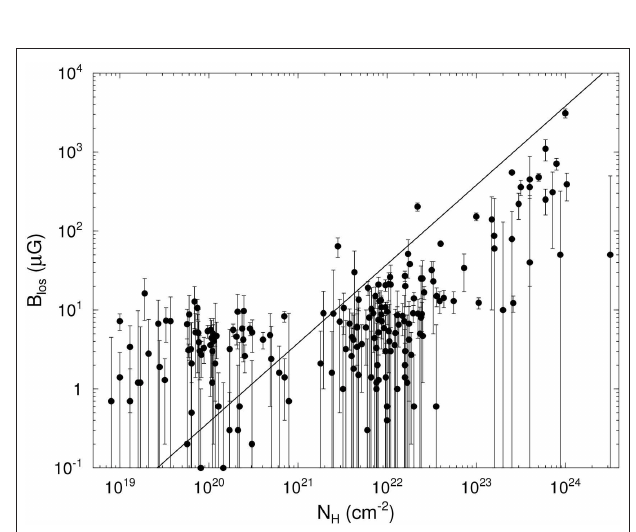
FIGURE 4 | H I, OH, and CN Zeeman measurements of B LOS vs.